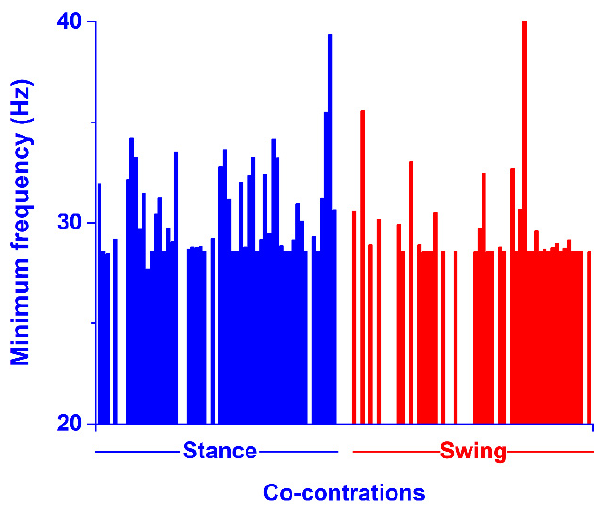
Figure 10. Average values of the minimum frequency computed in every co-contraction detected in time domain, as reported in Figure 7. Blue and red bars represent the minimum frequency of the co-contraction detected in stance and in swing, respectively. Each single bar represents the average value of the minimum frequency detected for each co-contraction in a single subject.